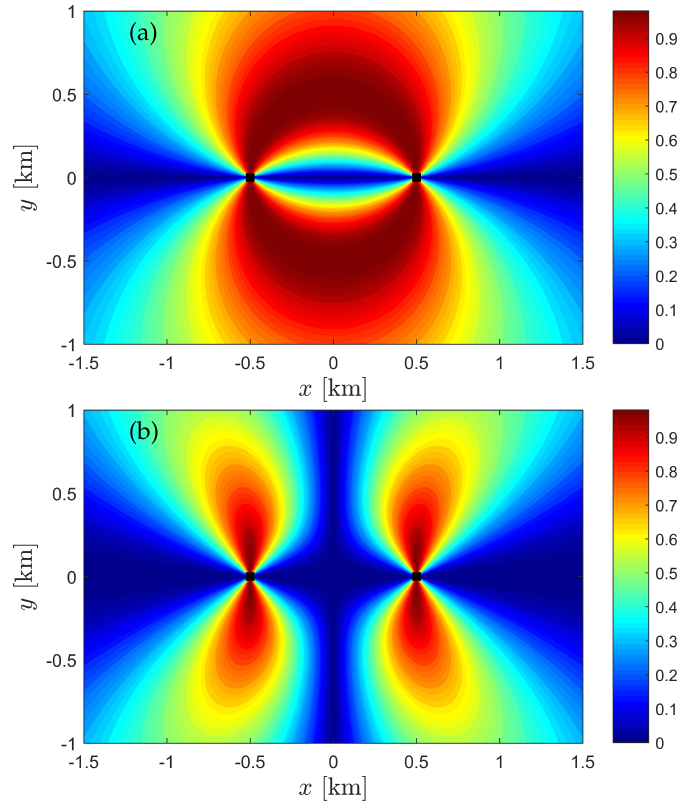
Figure 3. Spatial distribution of the determinant of M ( a ) and P ( b ) for a dual-Doppler scanning system with φ 1 = φ 2 = 0 ◦ assuming the wind is aligned with the x